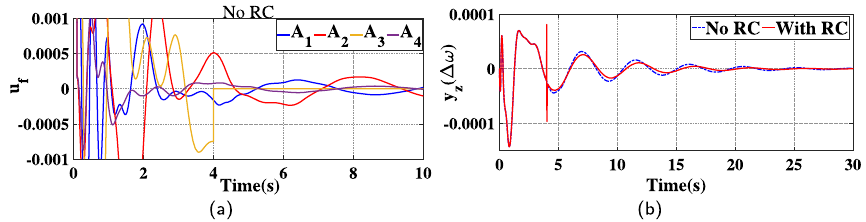
Fig. 9 Fault at actuator A 3 at t=4s: ( a ) Wide area control input to power system in absence of RC; ( b ) Comparison of system performance path (Change in rotor speed of G 3 ) with and without RC